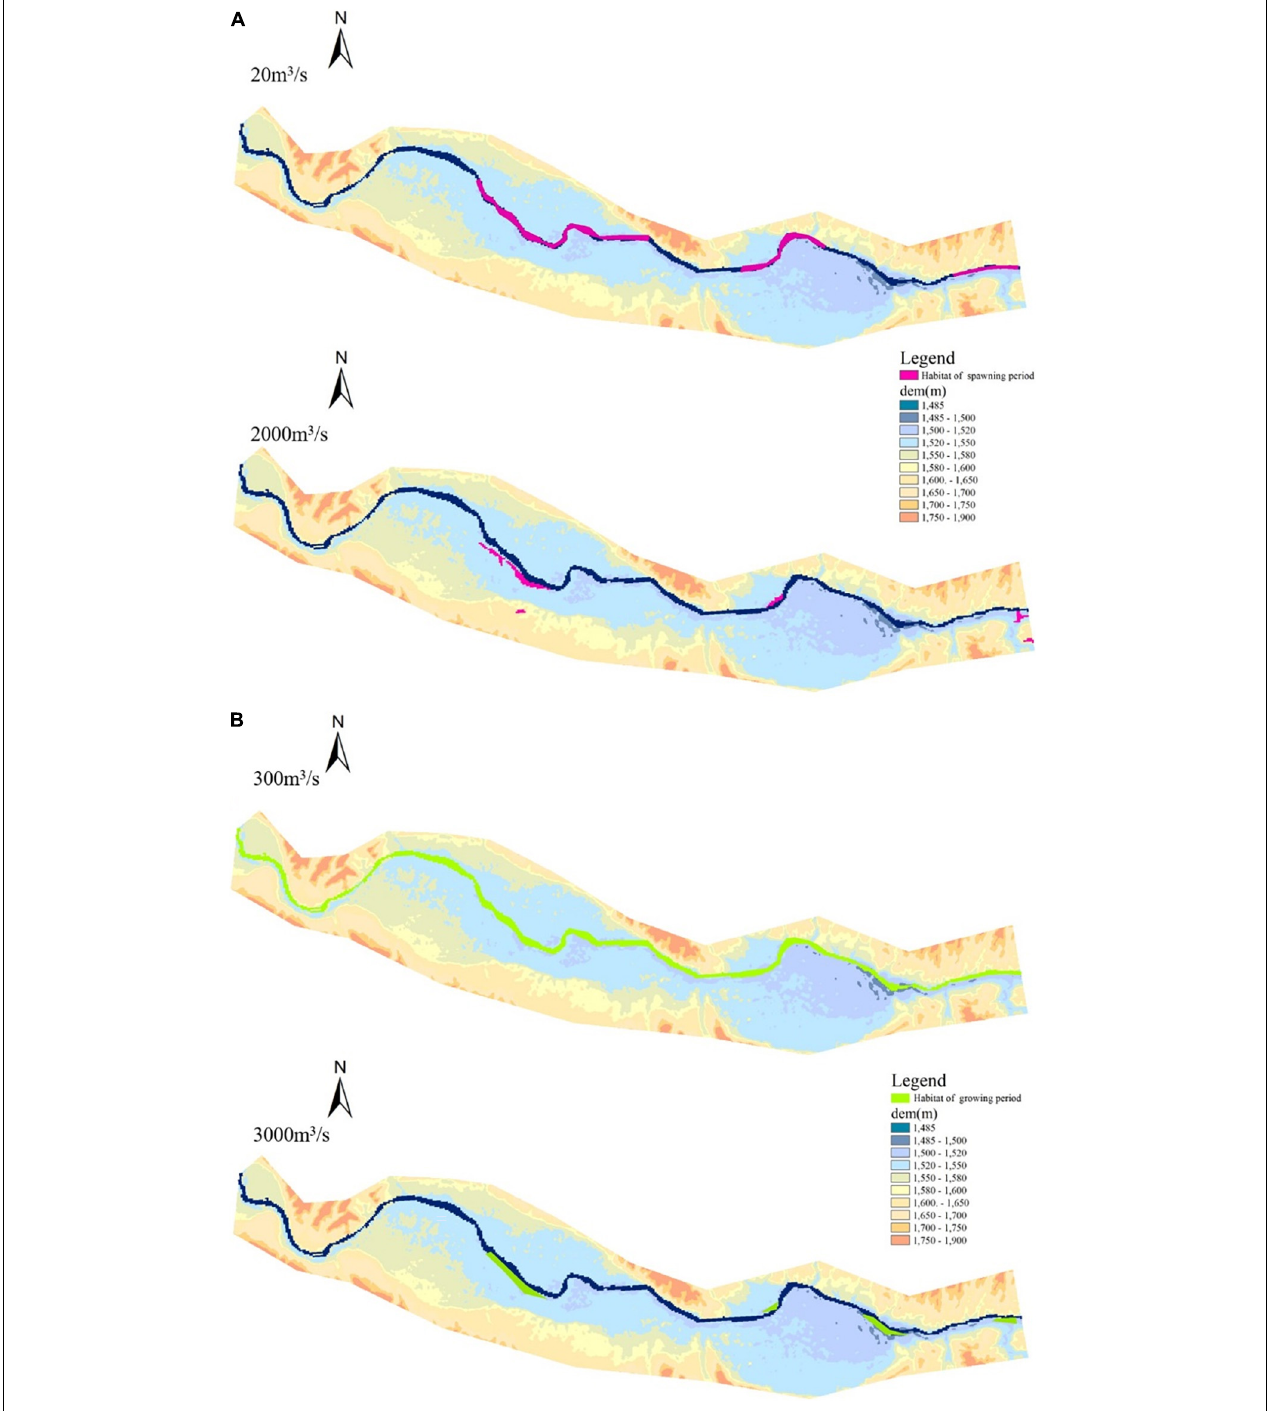
FIGURE 6 | The habitat distribution of Silurus lanzhouensis at different flow rates of LZ. (A) Habitat distribution in spawning period. (B) Habitat distribution in growing period.